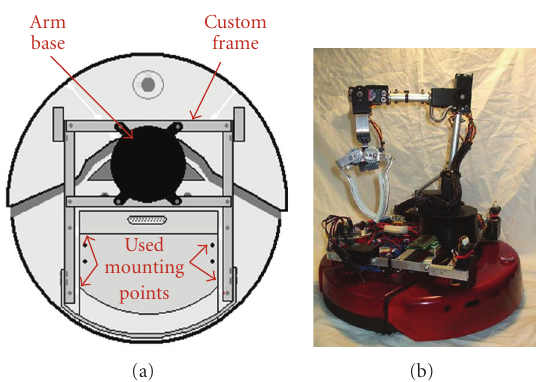
Figure 10: Custom frame design (a) and the robotic arm mounting